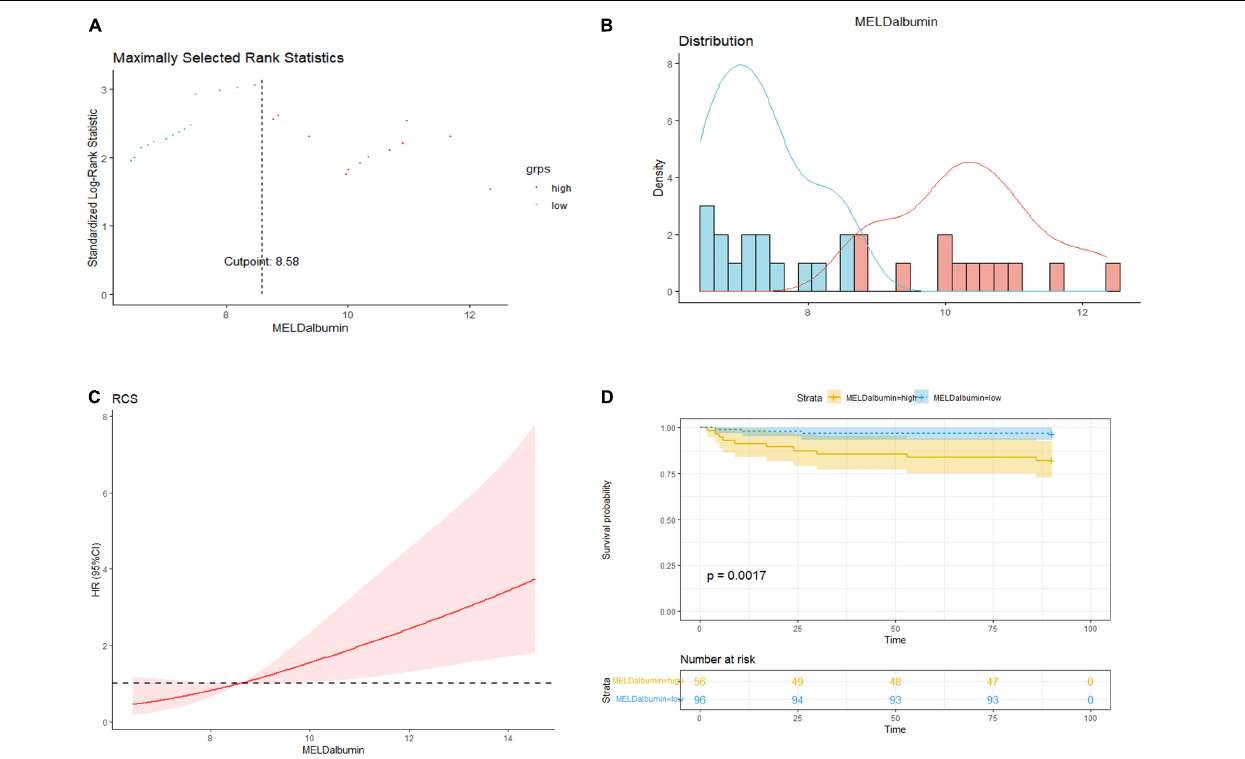
FIGURE 2 | Prognostic value of MELD-albumin score for in-hospital mortality. (A) The maximally selected log-rank statistics of MELD-albumin for survival indicated that optimal cutoff value of MELD-albumin was 8.58. (B) The distribution of MELD-albumin in patients of low MELD-albumin group (blue) and high MELD-albumin group (red) respectively based on survival. (C) Restricted cubic spline analysis for the relationship between MELD-albumin score and hazard ratio for in-hospital mortality in patients with the cutoff value of 8.58. (D) Kaplan–Meier curve analysis for the in-hospital mortality between high MELD-albumin ( ≥ 8.58) and low MELD-albumin ( < 8.58)